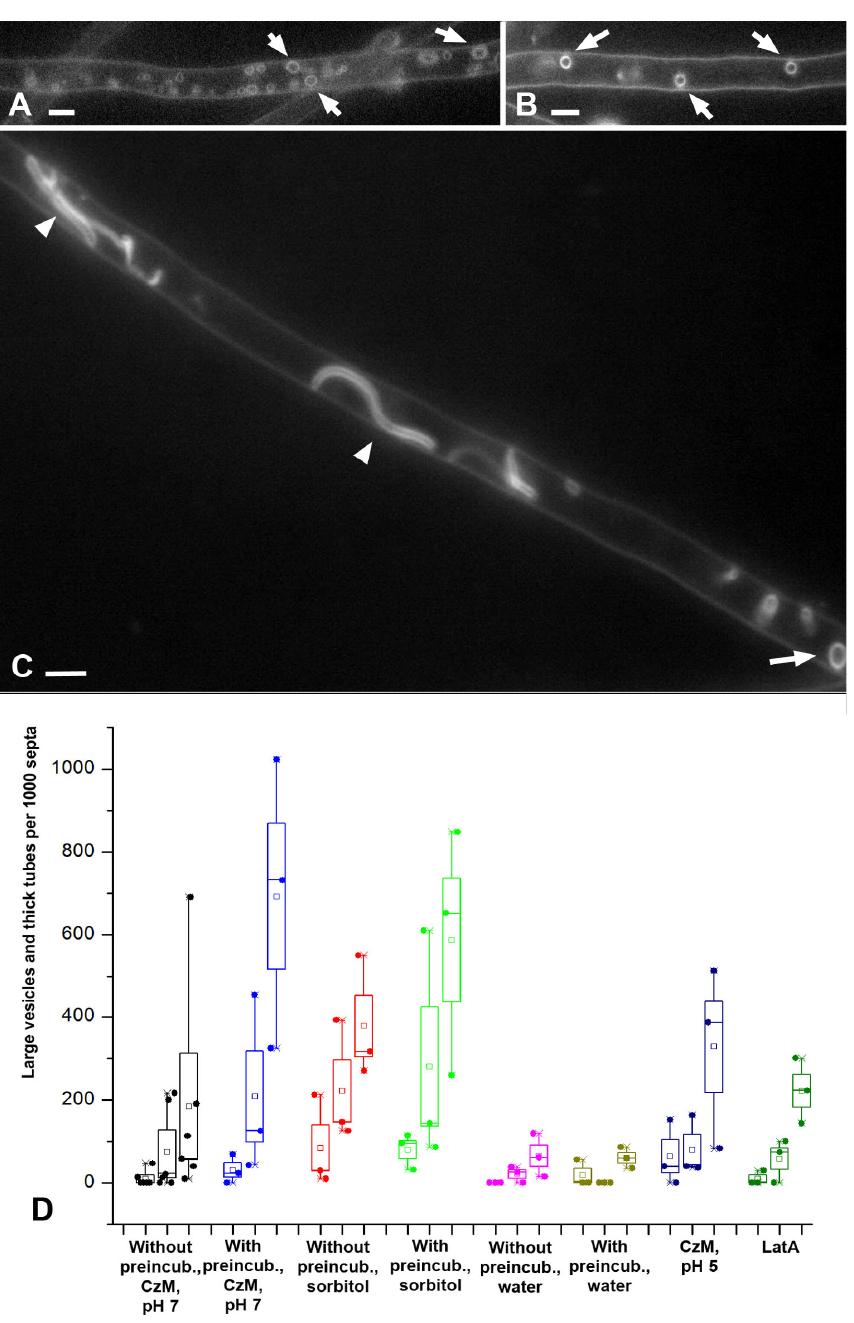
Figure 7. Large vesicles and thick tubes: fluorescent images and diagrams. Designations: white arrows—large vesicles, arrowheads—thick and intermediate tubes. ( A , B )—hyphae fragments of S. hirsutum in single focal plane. ( C )—Z-stacks summation of O. olearius . Scale bars are 5 µm. ( D )—influence of different variants of microscopic sample preparing on the formation of large vesicles and thick tubes in S. hirsutum. Legend: small square—mean; box—50% standard deviation, the